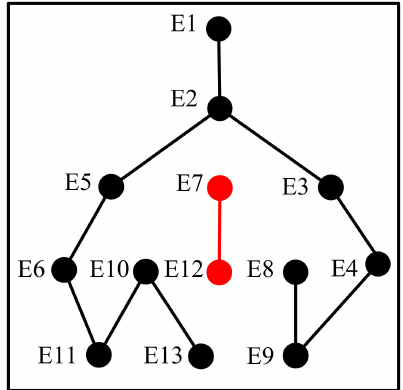
Figure 16. Failure restoration results using the traditional radial constraints modeling method.